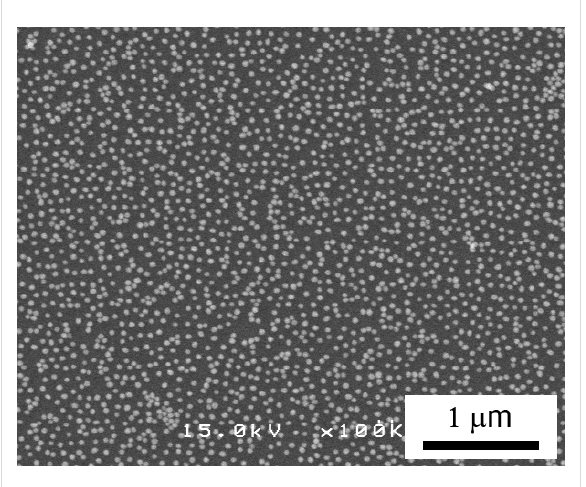
Figure 7: SEM image of the sample after step (i) using the amino- undecanethiol method.